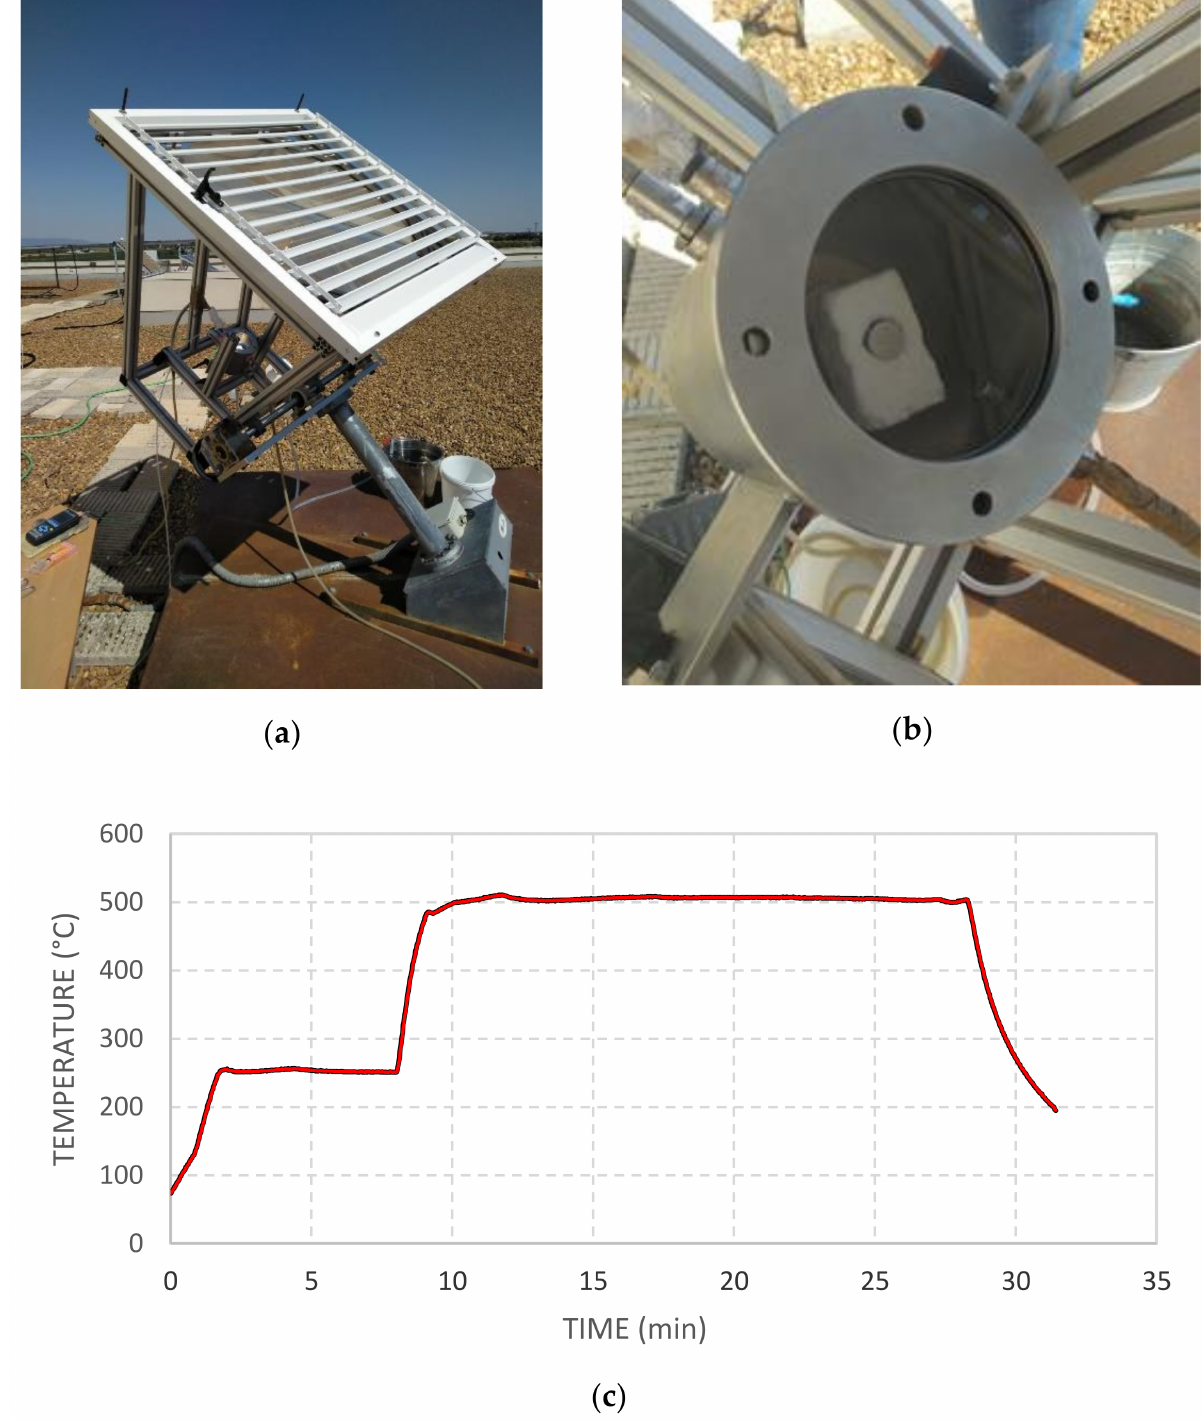
Figure 2. ( a ) Fresnel lens. ( b ) Reaction chamber and brown part localized in the alumina bed. ( c ) Sintering